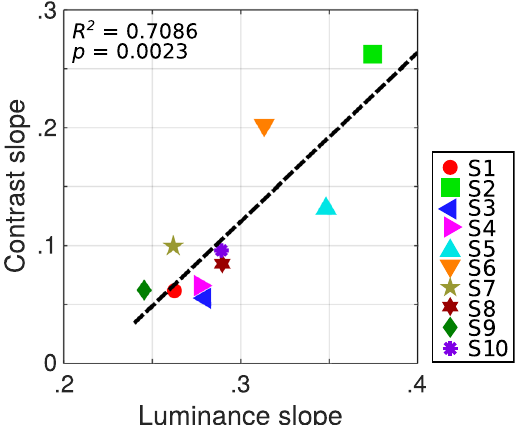
Figure 3. Correlation between luminance- and contrast-induced phenomenons. Regression slopes of the angular PSE for the interocular contrast difference as a function of the slopes of the angular PSE for the interocular luminance difference for the 10 subjects. The dashed line represents the least square regression: R 2 = 0.7086, p =